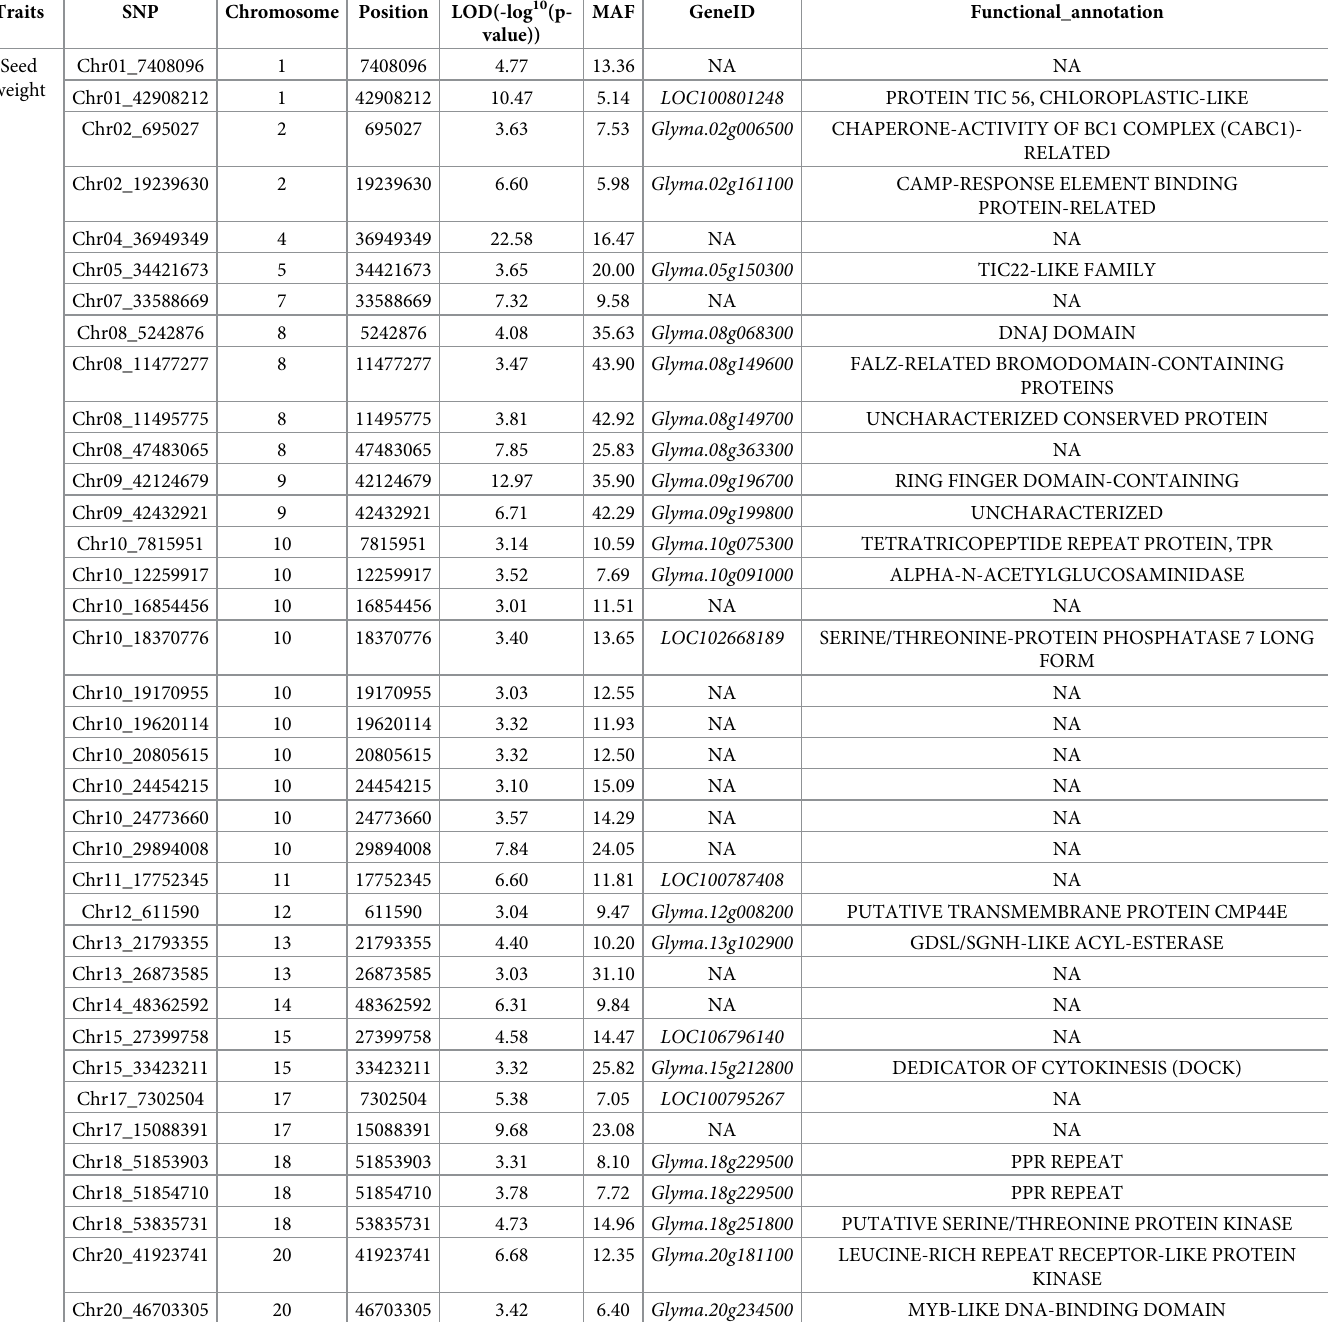
Table 2. Significant SNPs associated with the average seed-weight and yield over 3 years, chromosome and physical position of the significant SNPs, LOD (-log10 (p-value)) values, minor allele frequency at the SNP locus, and gene ID and functional annotation. Traits